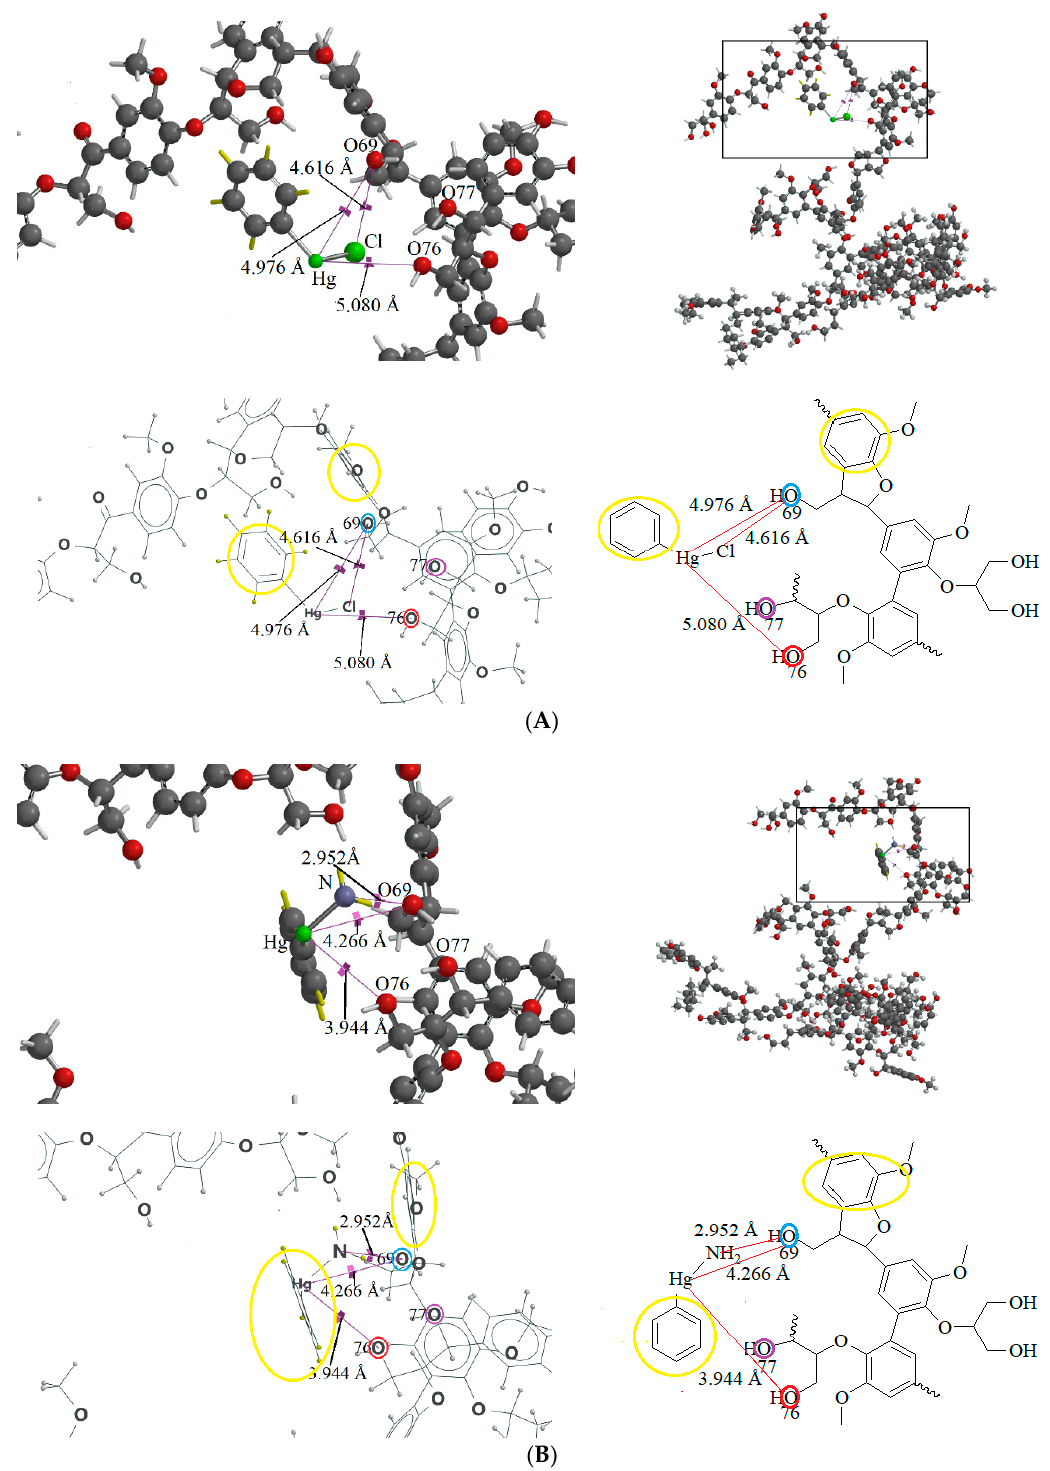
Figure 6. The theoretical interaction simulations between lignin and phenylmercuric chloride ( A ) and phenylmercuric amine ( B ) after the energy minimization. The same atoms in both 3D and 2D molecular structure drawings are colored for tracking purposes, as well as for the perception of mutual orientation alteration of molecules in the two cases. Aromatic rings are also circled in yellow for the same purpose. Note that the hydrogen atom of analyte in the 3D structure drawing is in yellow for easier distinction. Only the crucial part of the structure is shown in the 2D drawing for simplicity and